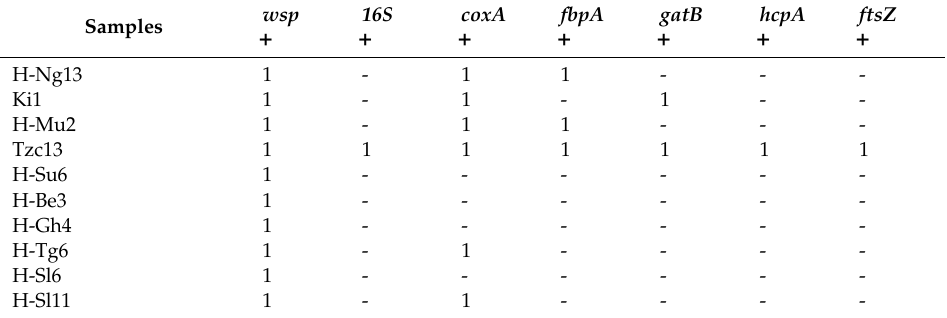
Table 2. Amplification of 16S rRNA and MLST genes for wsp + B. dorsalis samples. Numbers